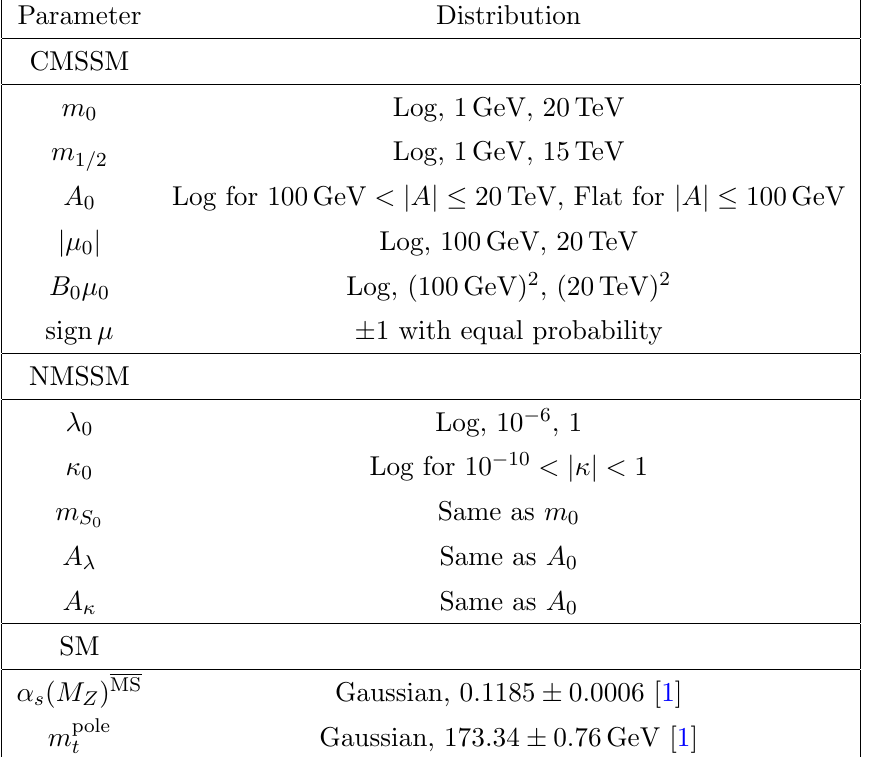
(cid:22) 0 via j j (cid:22) 0 and B 0 (cid:22) 0 are absent and j j